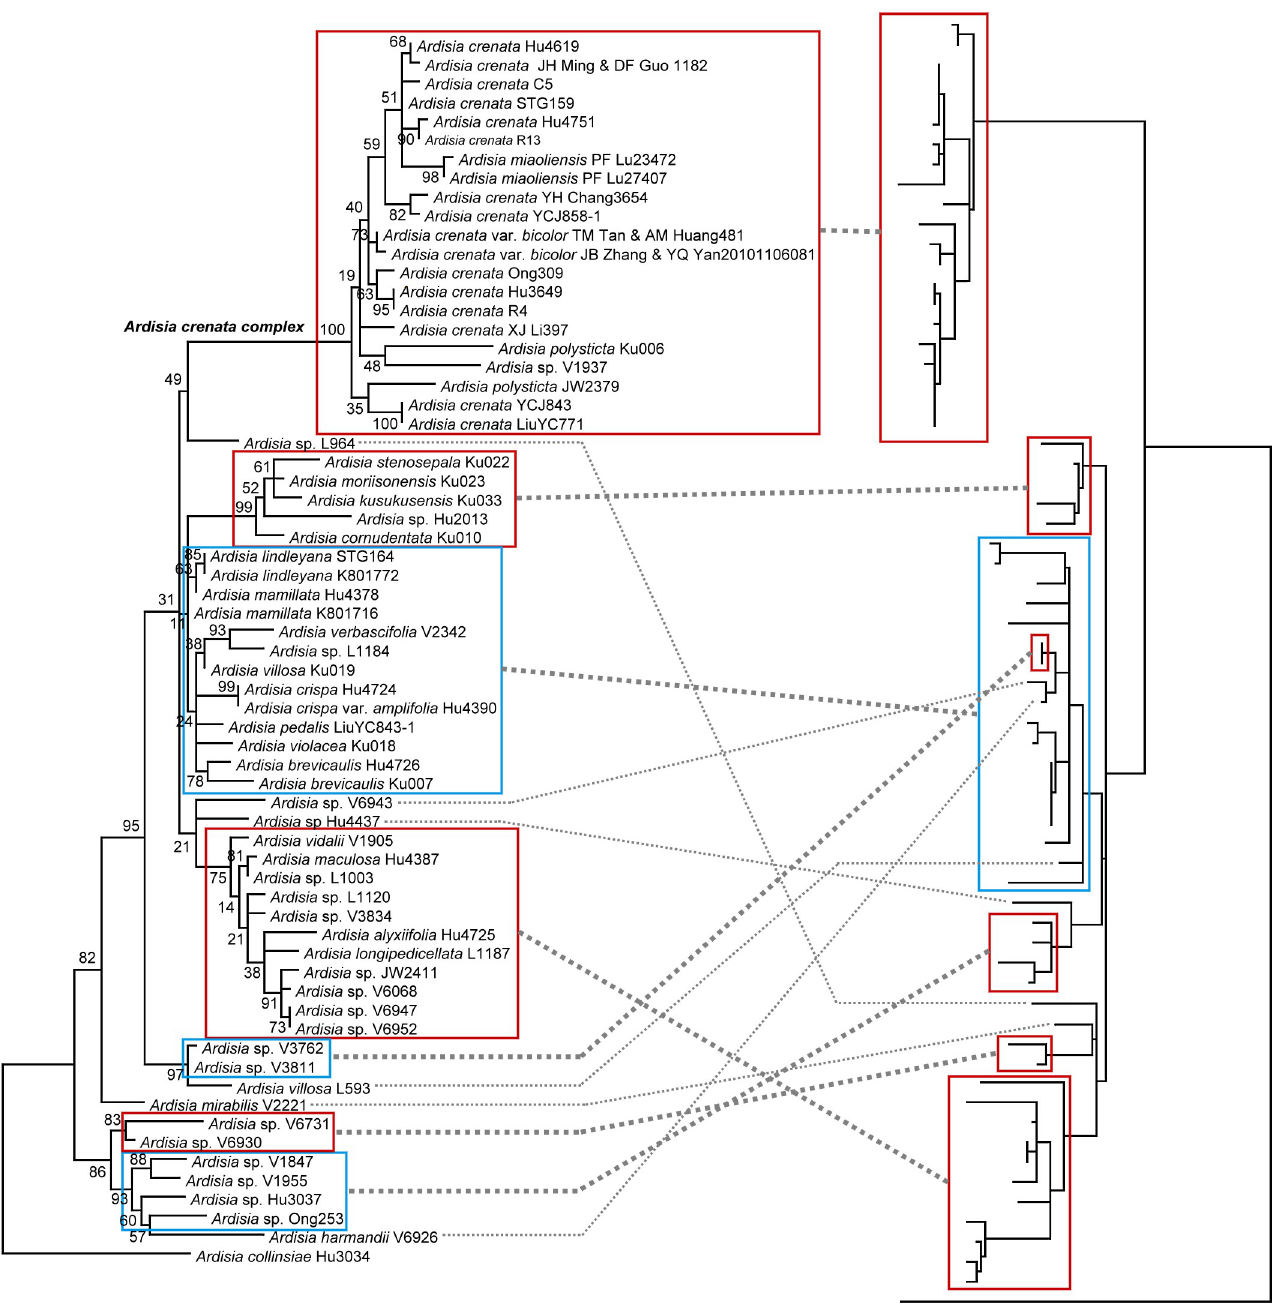
Fig 5. Tanglegram for Ardisia and their symbiotic bacteria. Symbiont species or clades (subtrees) are connected to their host by a gray line. Maximum likelihood trees based on the nrITS and plastid sequences ( psbA-trnH and rpl32-trnL ) for the host (left) and the 16S-23S rRNA of their symbiotic bacteria (right). Red box indicates monophyletic clade, and blue box indicates non-monophyletic clade. Numbers in the left tree are ML bootstrap support values. Collection numbers were labeled after species names. https://doi.org/10.1371/journal.pone.0261188.g005 two phylogenies. On the other hand, at least three clearly host switching events were discov- ered. Ardisia sp. ‘Hu4437’, A . harmandii ‘V6926’, and Ardisia sp. ‘L964’ were obviously in dif- ferent positions between the host tree and the symbiont tree. Other phylogenetic position discordance in the tanglegram can be seen for A . mirabilis ‘V2221’ and A . villosa ‘L593.’